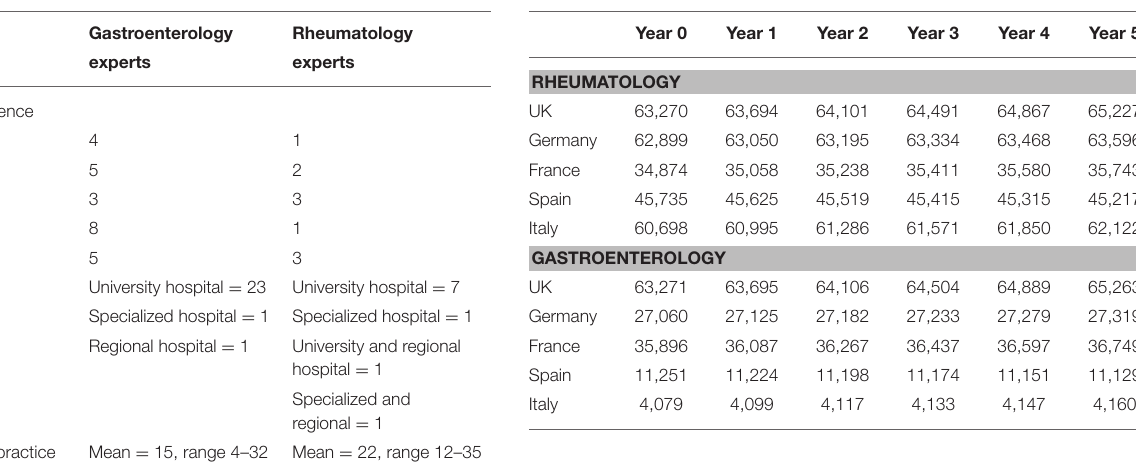
TABLE 1 | Respondent demographics (round 1) n = 35. TABLE 2 | Number of patients eligible for treatment with